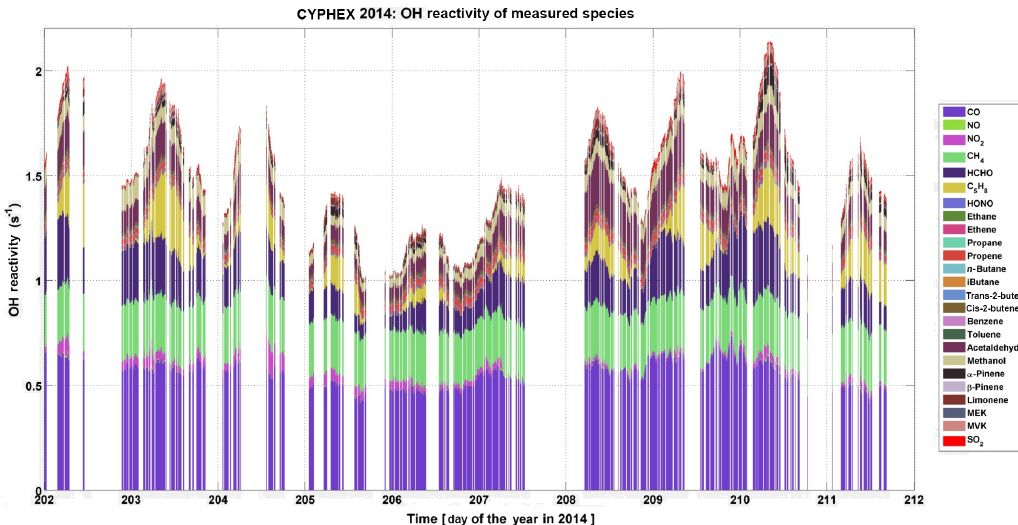
Figure 4. Calculated OH reactivity of various chemical species measured during CYPHEX.